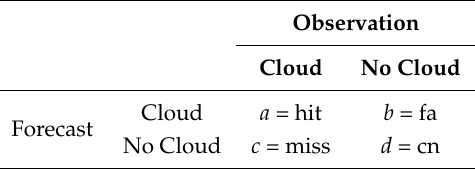
Table 1. Contingency table with the elemtents hit, missed, false alarm (fa) and correct negative